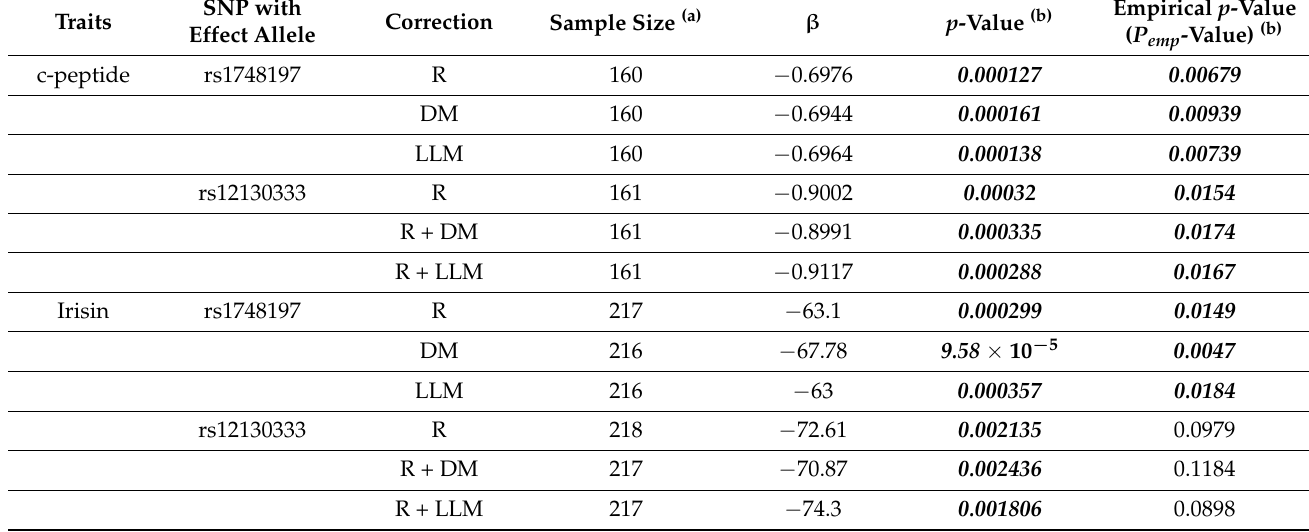
Table 2. Results of association tests for the two study variants with the levels of c-peptide and irisin, using genetic models based on additive mode of inheritance. Of the 28 traits studied for association with the two variants, only 17 were found independent of one another. Significant p -values passing the threshold for multiple testing ( p -value ≤ 0.003 = 0.05/17) and significant P emp -values ≤ 0.05 are highlighted in bold and italic font. Association tests were adjusted for age, sex (regular correction) and further confounders of diabetes medication (DM) and lipid-lowering medication (LLM). Association signals with other traits not meeting the significance dictated by p -value threshold adjusted for multiple testing are given